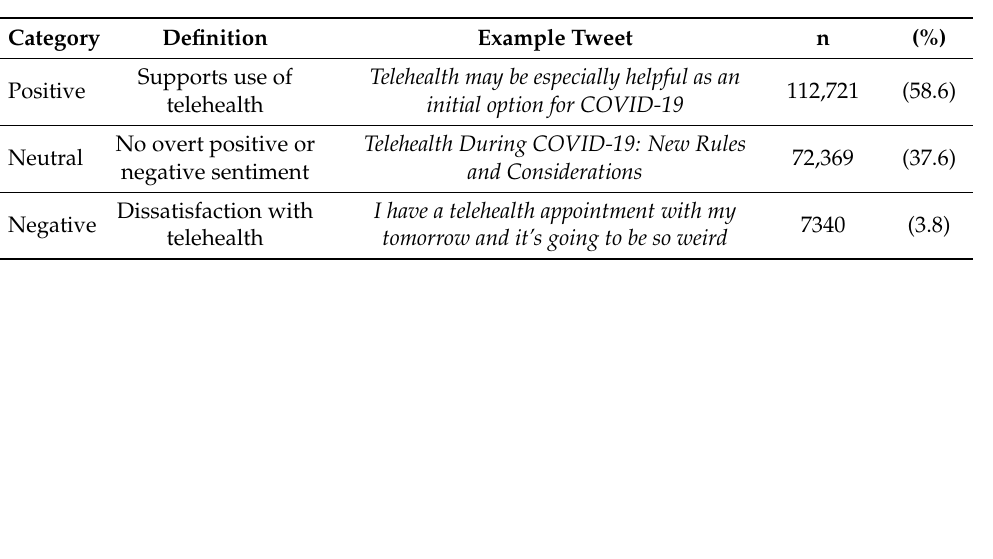
Table 3. Distribution of tweets by